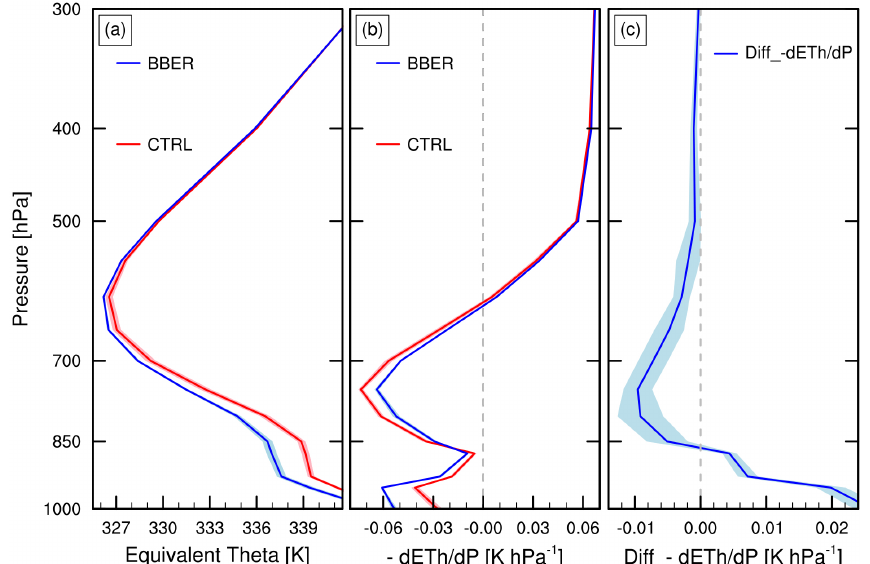
; KhPa − 1 ) averaged over ∂P